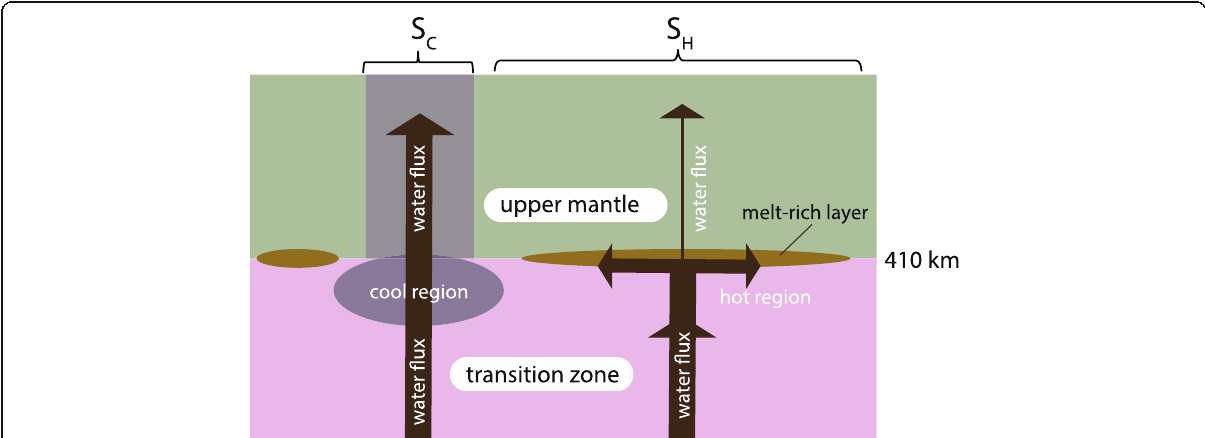
Fig. 9 Processes of water transport across the 410 km with heterogeneous temperature. In the hot region (area S H (a majority of regions)), melts are dense and spread on the 410-km boundary and eventually be entrained into the transition zone (Bercovici and Karato 2003; Karato et al. 2006). Only a small amount of water is transported upward by the residual solids to define the composition of the asthenosphere (Karato 2012). In the cool region (area S C ), melt is buoyant and if there is enough amount of buoyant melt present (a case X MTZ ≥ X C 2 (shown here)), substantial degassing from the MTZ will occur